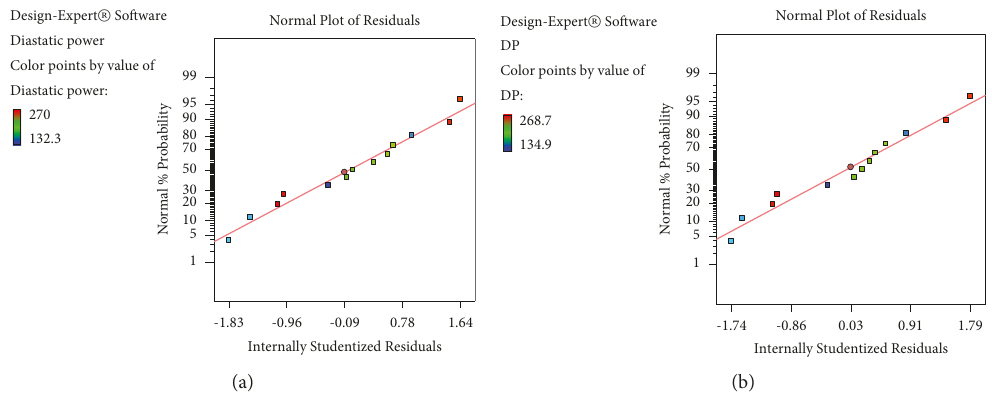
Figure 6: Normal probability plot of residuals for (a) barley diastatic power and (b) quinoa diastatic